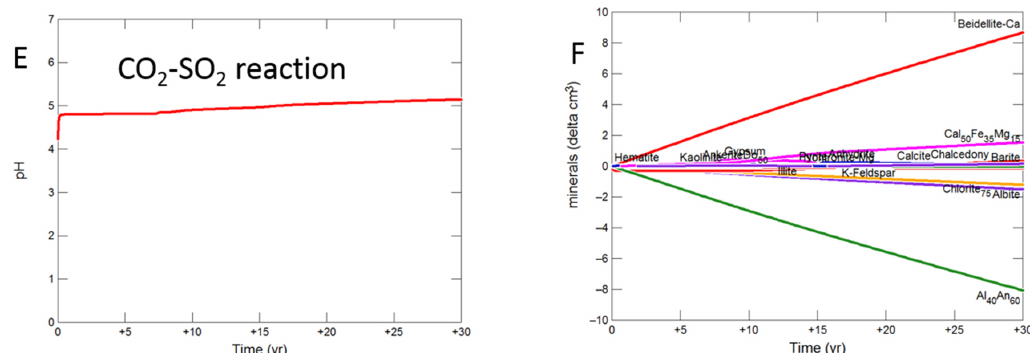
Figure 8. Up ‐ scaled calcite cemented cap ‐ rock, reaction over 30 years. Reaction with CO 2 ‐ SO 2 ‐ O 2 ( A ) predicted pH; ( B ) predicted change in mineral volumes (delta cm 3 ), where positive values indicate mineral precipitation, and negative values mineral dissolution; Reaction with CO 2 ( C ) predicted pH; ( D ) predicted change in mineral volumes; Reaction with CO 2 ‐ SO 2 ( E ) predicted pH; ( F ) predicted change in mineral volumes.